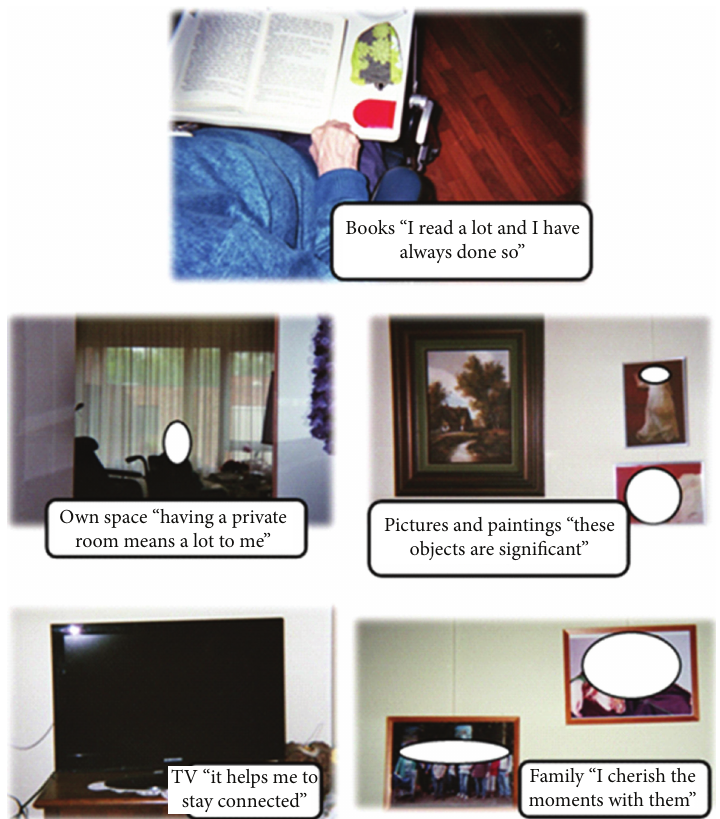
Figure 1: Example of the top-5 pictures of one of the participants, showing personal belongings, a private room, and social relationships. The top-5 ranking does not necessarily show building-related photos